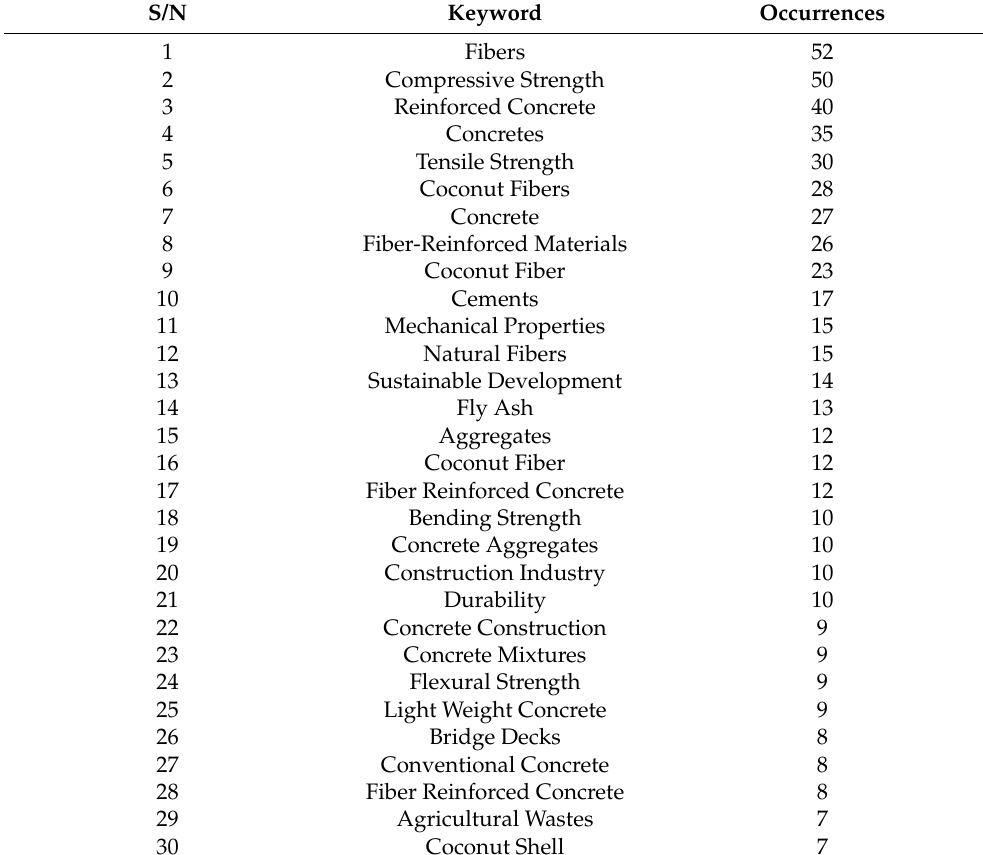
Table 2. The 30 leading frequently employed keywords in the research of coconut-fiber-reinforced concrete.